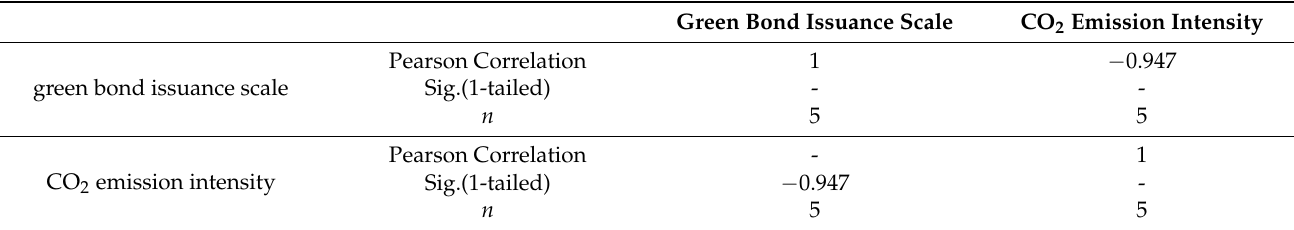
Table 4. Correlation between green bond issuance scale and CO 2 emission intensity.